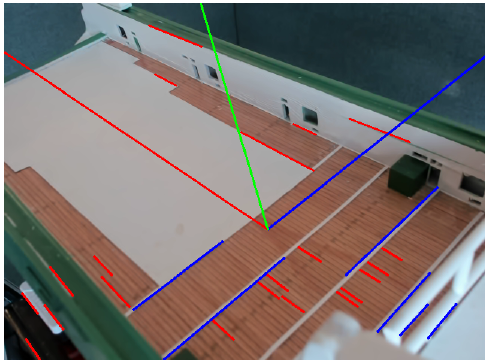
Figure 3: An illustration of clustered lines in the image. Lines of same color are assumed parallel, and the rotation from camera down to the ship deck is illustrated in the form of an